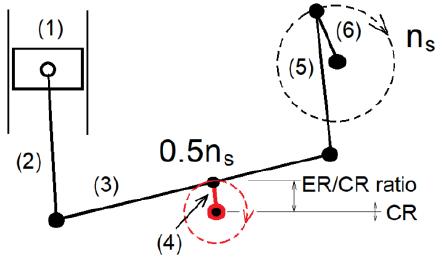
Fig. 6. Piston-crankshaft linkage of the new conception of the rocker engine